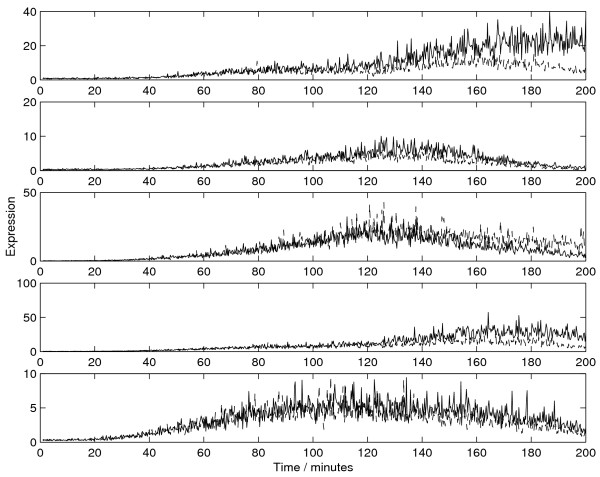
Simulated ground truth signals with noise added. Gene expression profiles of the same genes as in Figure 6 with measurement noise added. Small trends (for example lowest sub figure) in the signals are covered by noise. Reference signal is shown with solid and test signal with dashed line.